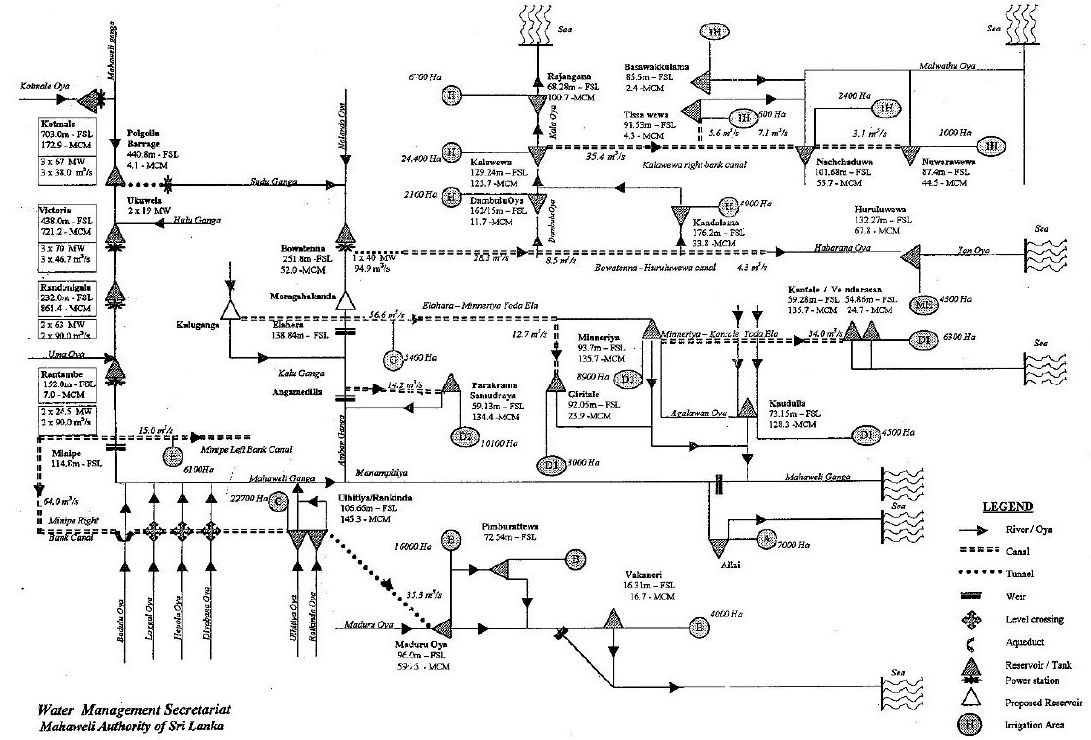
Figure 3. A cross-section of the dam, tank and canal network of the surface irrigation system created through the Mahaweli Development Project [31].